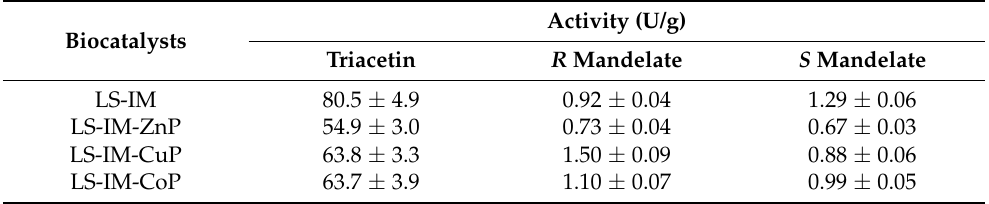
Table 4. Specific activity of different biocatalysts with 50 mM R - or S -methyl mandelate and 50 mM of triacetin (pH 7, 25 ◦ C). Experiments were performed as described in the Methods section.